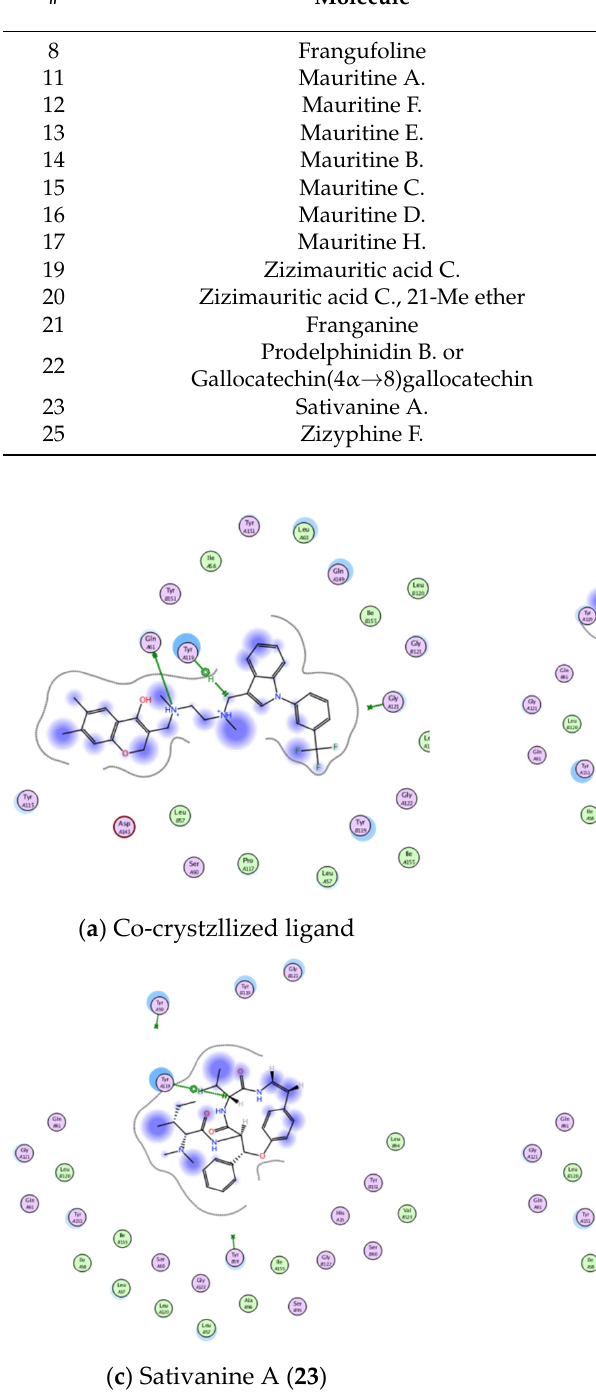
Figure 11. Showing 2D-binding interactions of co-crystallized ligand ( a ) and molecules 2 , 23 , 25 ( b – d , respectively) within active sites of TNF α active site (PDB ID: 2AZ5). Even though, 8 molecules succeed to show bonding interactions with amino acid On the other hand, only 4 molecules showed better interaction energy than residues of 6B8Y actives site as shown in Figure 12 and Table co-crystallized ligand within transforming growth factor beta receptor type 1 kinase domain (TGFBR1 PDB ID: 6B8Y, resolution 1.65 Å) active site, while the remaining mol- ecules showed either comparable or lower binding free energy compared to co-crystallized ligand (Table 4). Table 4. Interaction binding energy (kcal/mol) and binding accuracy (RMSD; Å) of ZFE-derived compounds and the co-crystallized ligand within TGFBR1 kinase (PDB ID: 6B8Y; 1.65 Å). #